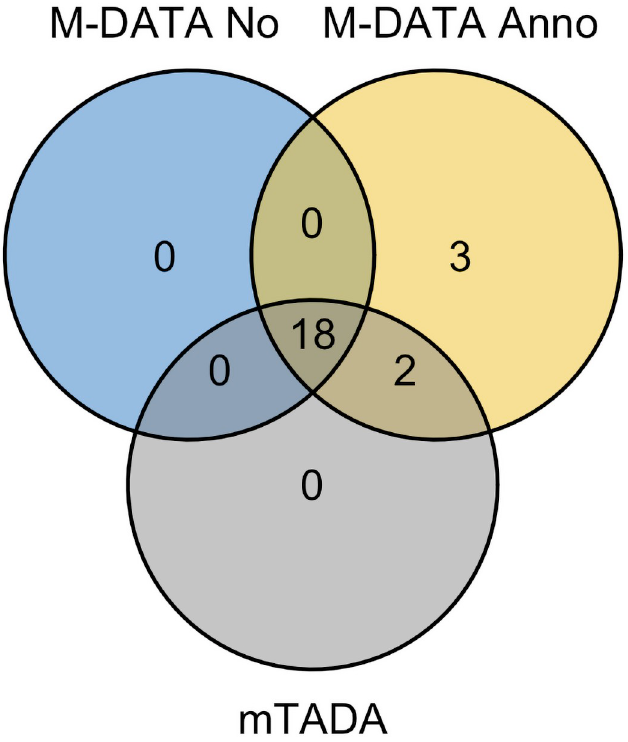
Fig 7. Venn diagram of genes identified by M-DATA and mTADA for CHD. M-DATA multi-trait model with annotations identified 3 additional genes (CDK13 , SAMD11 and RPL5)